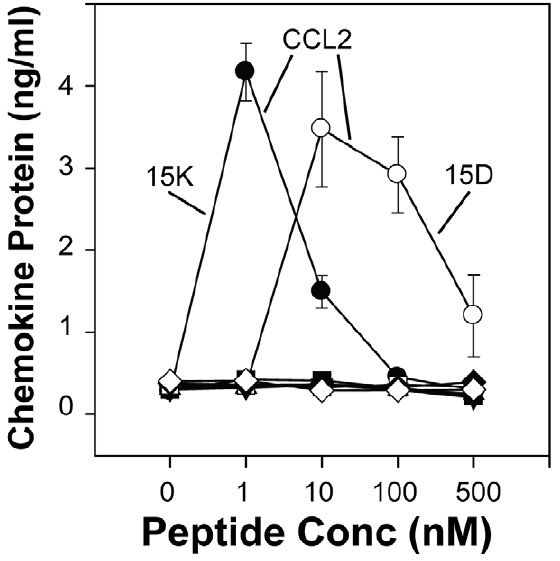
Figure 6. Induction of chemokine expression following peptide administration. Cells were treated with 15K and 15D, at the designated concentrations, and supernatants were collected from the cultures at 48 h, and subjected to ELISA for the determination of CCL2, CCL3, CCL4, CCL5 and CXCL12 levels. Levels of chemokine at 24, 72, and 96 h were also monitored for chemokine levels (data not shown). Data are presented as the mean ( 6 SD) of triplicate determinations, and the data are representative of the results from experiments with three donors.